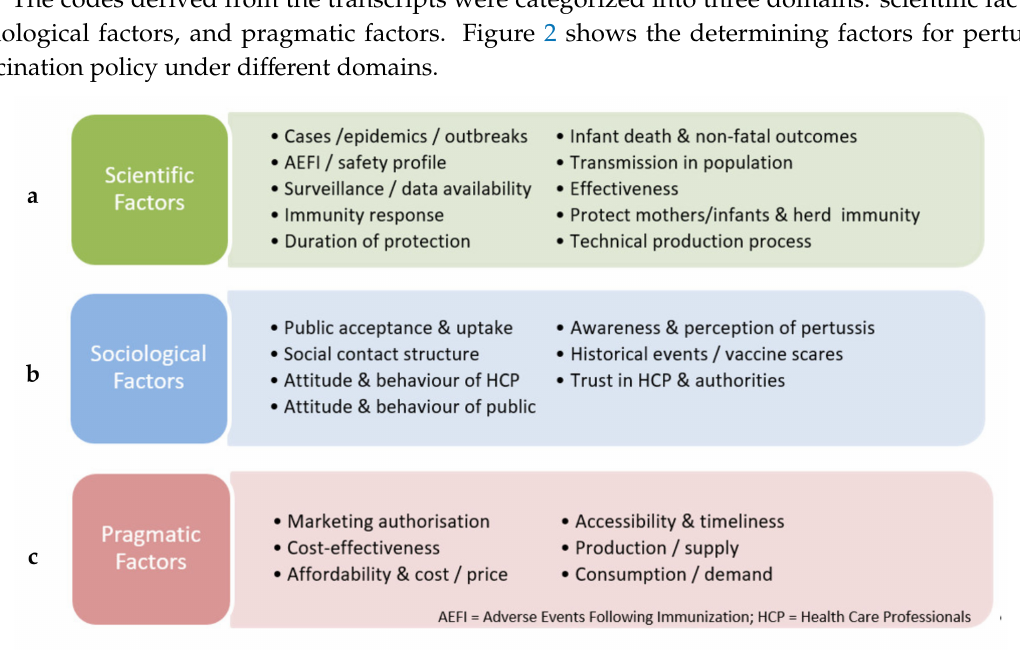
Figure 2. Determining factors of pertussis vaccination policy: ( a ) scientific factors; ( b ) sociological factors; ( c ) pragmatic